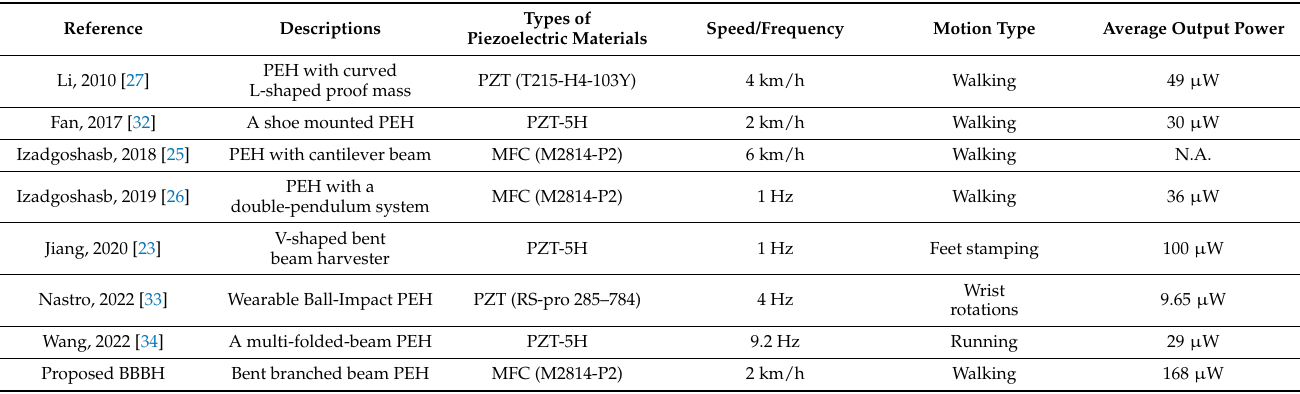
Table 10. Performance comparison of the BBBH with existing